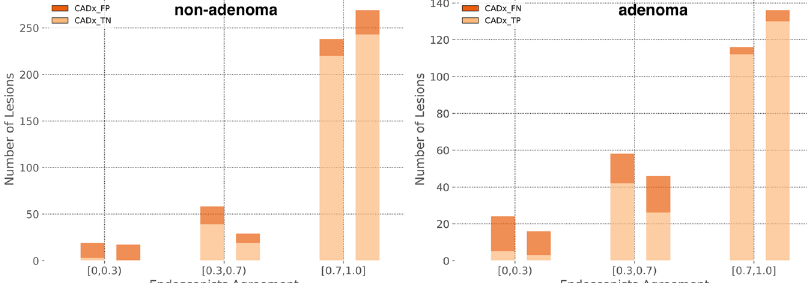
Fig. 3 Graphical visualization of agreement between reviewer predictions and histology. Results for polyps with non-adenomatous and adenomatous histology are reported in left and right plots, respectively. In each box, the rightmost pair of bins reports polyps for which 70 – 100% of the endoscopists' predictions are in agreement with histology, while the leftmost pair of bins reports polyps for which less than 30% of the endoscopists' predictions are in agreement with histology. Each bin pair reports non-experts on the left and experts on the right. The distribution suggests that most of CADx FPs and FNs are polyps where reviewers disagree with each other, or are unanimously in disagreement with